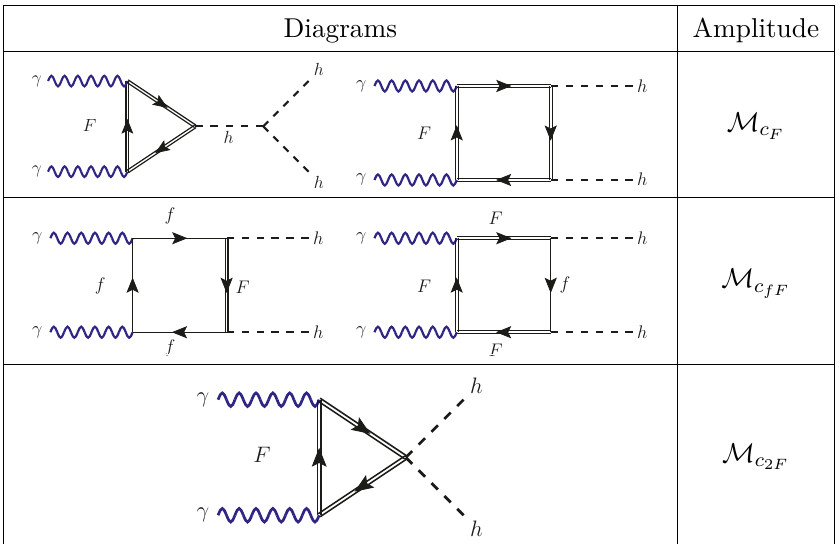
Table 6 . Additional diagrams with top partners, with the corresponding partial amplitudes as defined in the